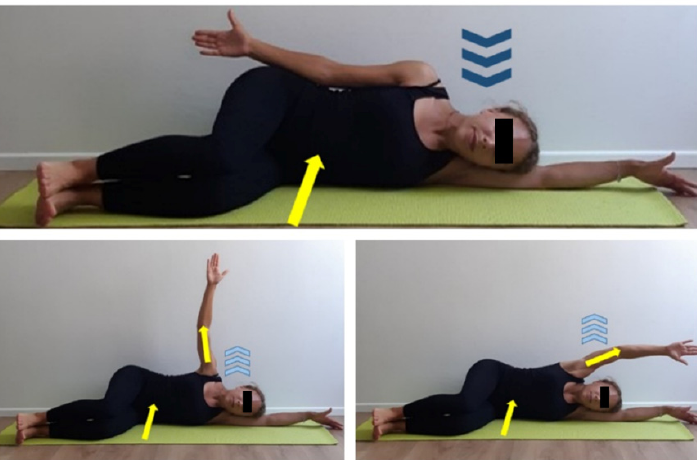
Figure 9. Scapulohumeral mobilization exercise in lateral decubitus position. Lateral decubitus, both legs and thighs 90 degrees flexed. Keep floor arm straight upward and rest head on it. Set top arm straight on body side, hand palms facing forward. Activate core muscles (yellow arrow). Inhale (dark blue arrows), exhale (light blue arrows) and perform a top upper limb abduction (yellow arrow) until bringing it parallel to the floor one (yellow arrow). Imagine hand is drawing a big semicircle during arm movement and focus on keeping upper limbs stretched and core muscles activated (yellow arrows). Inhale and slowly get back to start position. Two sets of 8 repetitions, 30 s recovery.